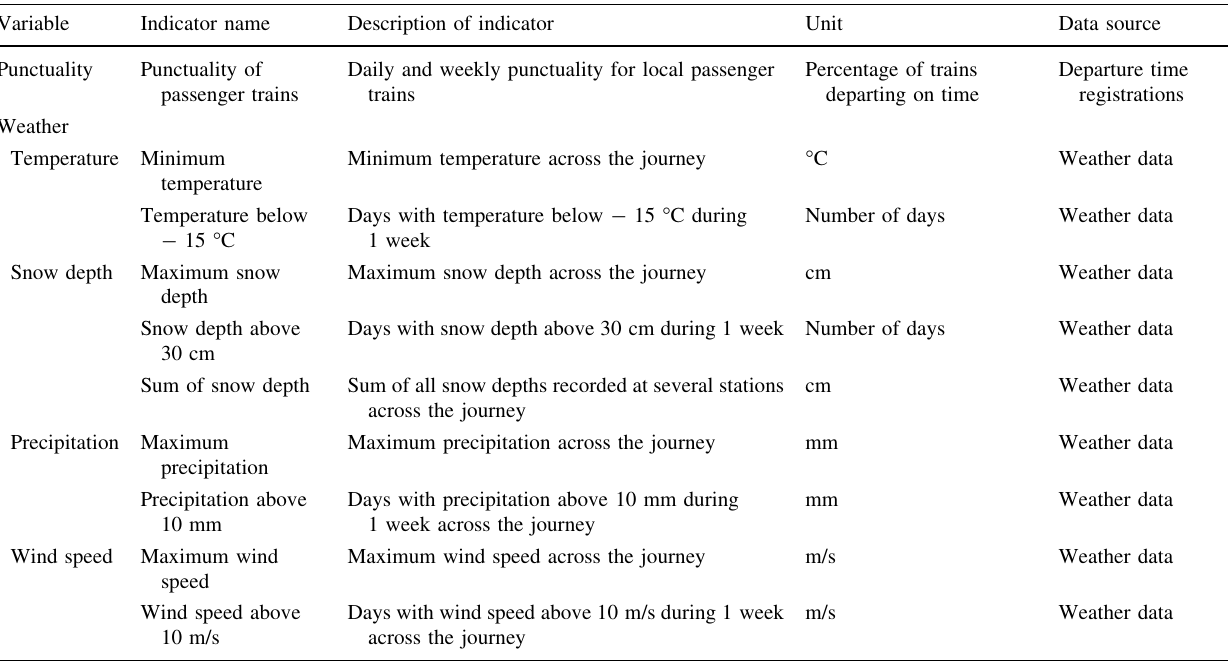
Table 1 Overview of variables, punctuality and